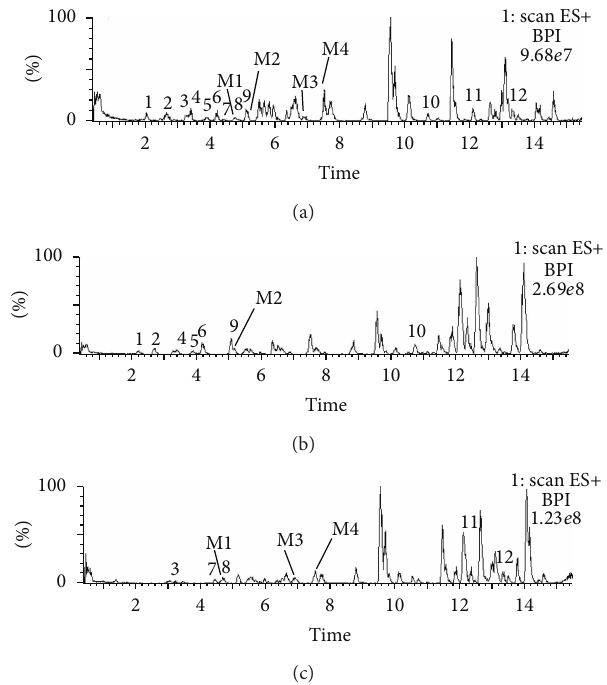
Figure 4: TIC chromatograms of serum samples: (a) WJSH capsule; (b) RadixetCaulisAcanthopanacisSenticosi alone;(c)WJSHcapsule without Radix et Caulis Acanthopanacis Senticosi . Peaks: 1, syringin; 2, protocatechuic acid; 3, liguiritin; 4, ferulic acid; 5, isofraxidine; 6, chlorogenic acid; 7, liqustilide; M1, M2, M3, and M4 stand for metabolites 1, 2, 3, and 4, respectively.